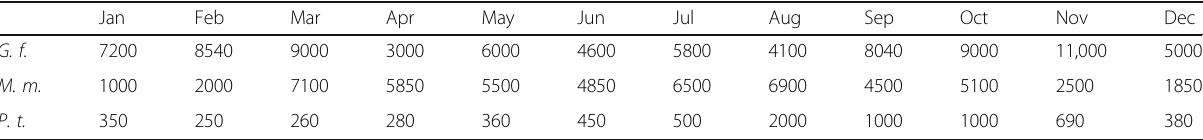
Table 2 Numbers of individuals of P.thysanopterus alive and killed by the predatory bug, M. moraguesi , over l00 infested leaves of F. nitida in the year 2016 Case Alive Preyed 650 Total Predation rate Table 3 Numbers of G. ficorum , M. moraguesi , and P. thysanopterus individuals (over l00 infested leaves) in the year 2017 Jan M. m. P. t.